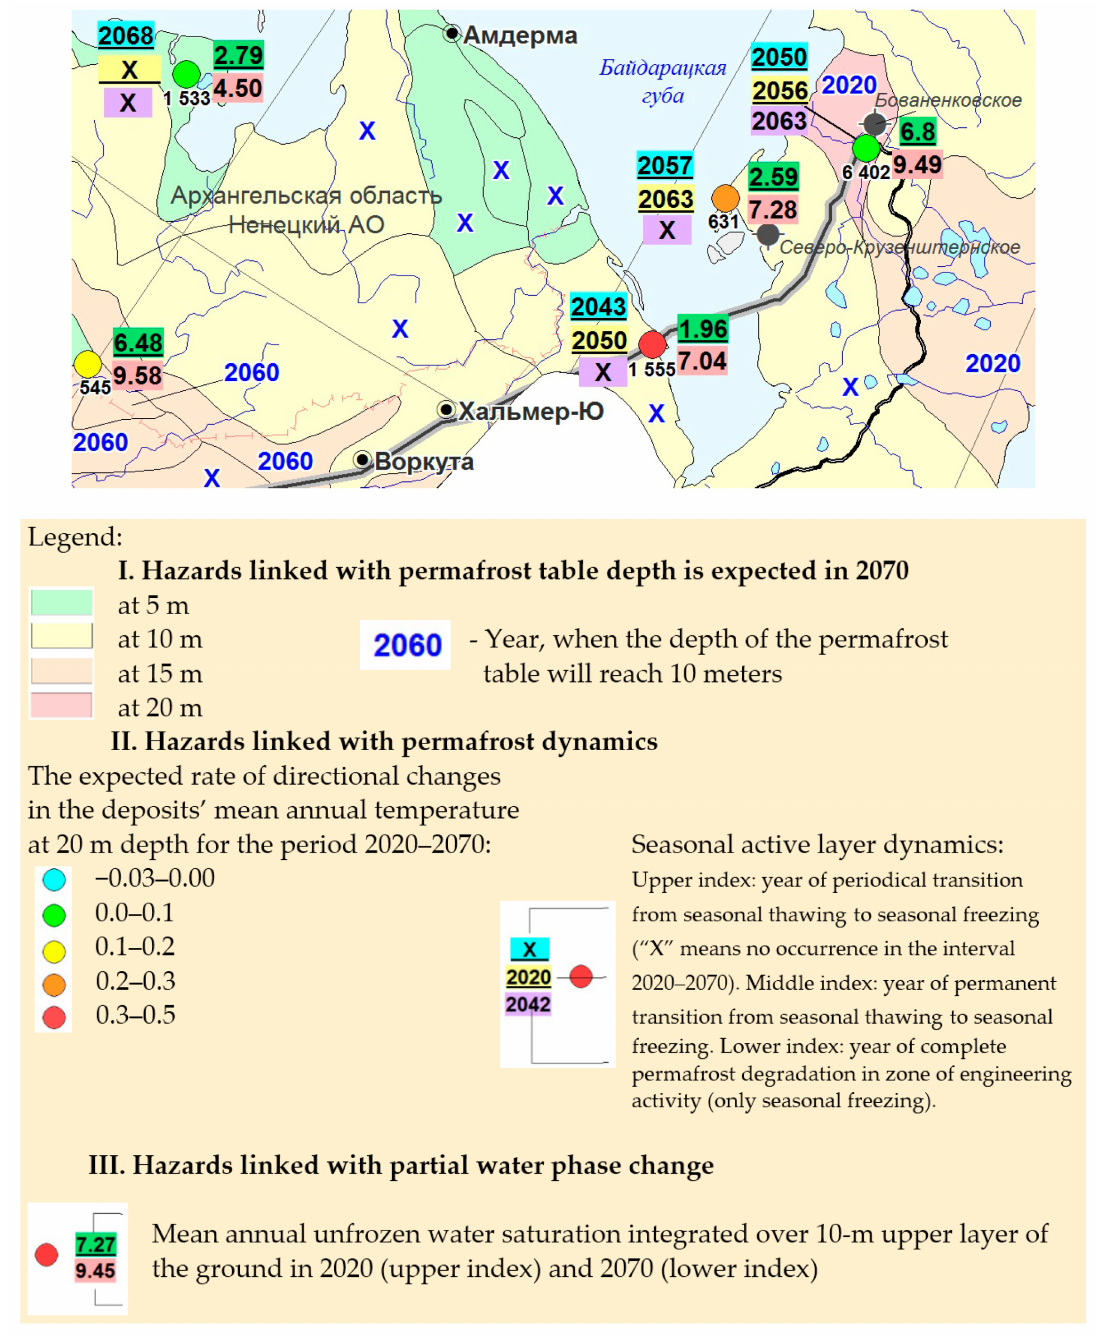
Figure 5. The example layout of the map scheme of expected permafrost hazards (undisturbed conditions). The legend peculiarities are described in the